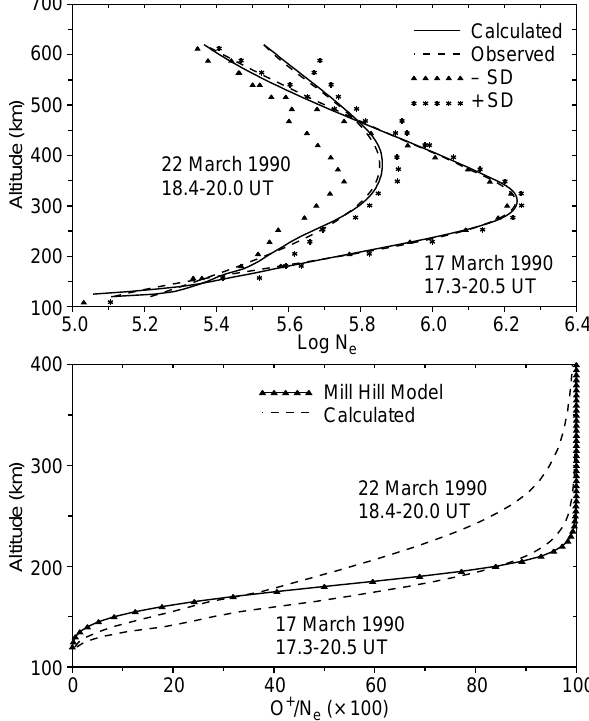
Fig. 4. Same as Figure 3 but for the disturbed day of March